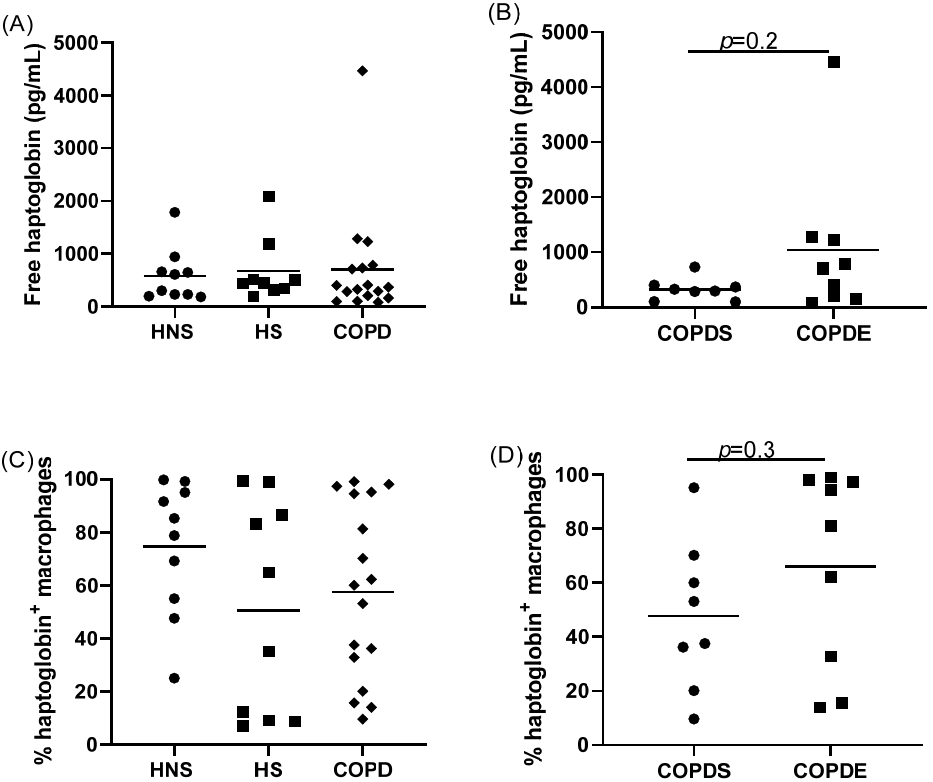
Figure 3. Sputum haptoglobin expression. The levels of haptoglobin were quantified in the sputum supernatants of n = 10 healthy non-smokers (HNS), n = 10 healthy smokers (HS) and n = 17 COPD patients by ELISA ( A ). Haptoglobin levels were compared between n = 8 COPD current smokers (COPDS) and n = 9 COPD ex-smokers (COPDE) ( B ). The percentage of haptoglobin+ sputum macrophages were compared between HNS, HS and COPD patients ( C ) and between COPDS and COPDE ( D ). Data are presented as individual values with mean .